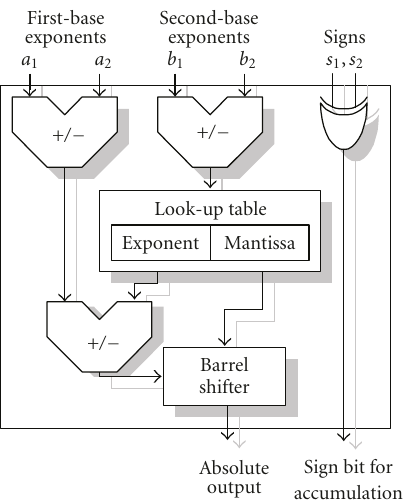
Figure 2: One-bit sign 2DLNS inner product computational unit.